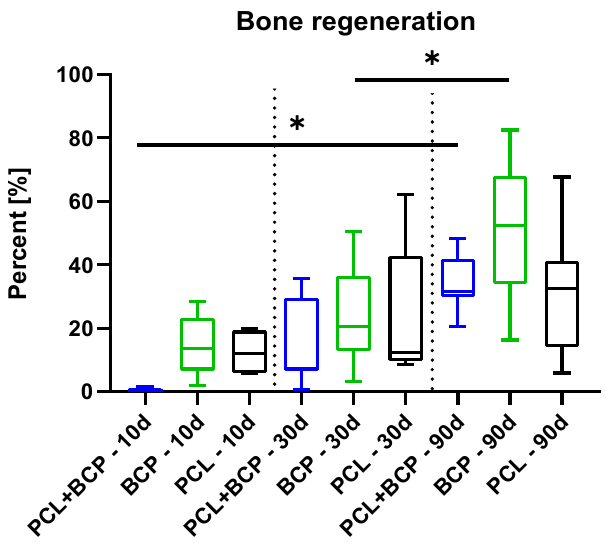
Figure 10. Histomorphometrical results of the measurements of bone regeneration (* = intraindi- vidual differences, * p < 0.05). Table 4. Results of the histomorphometrical tissue distribution measurements (in percent).